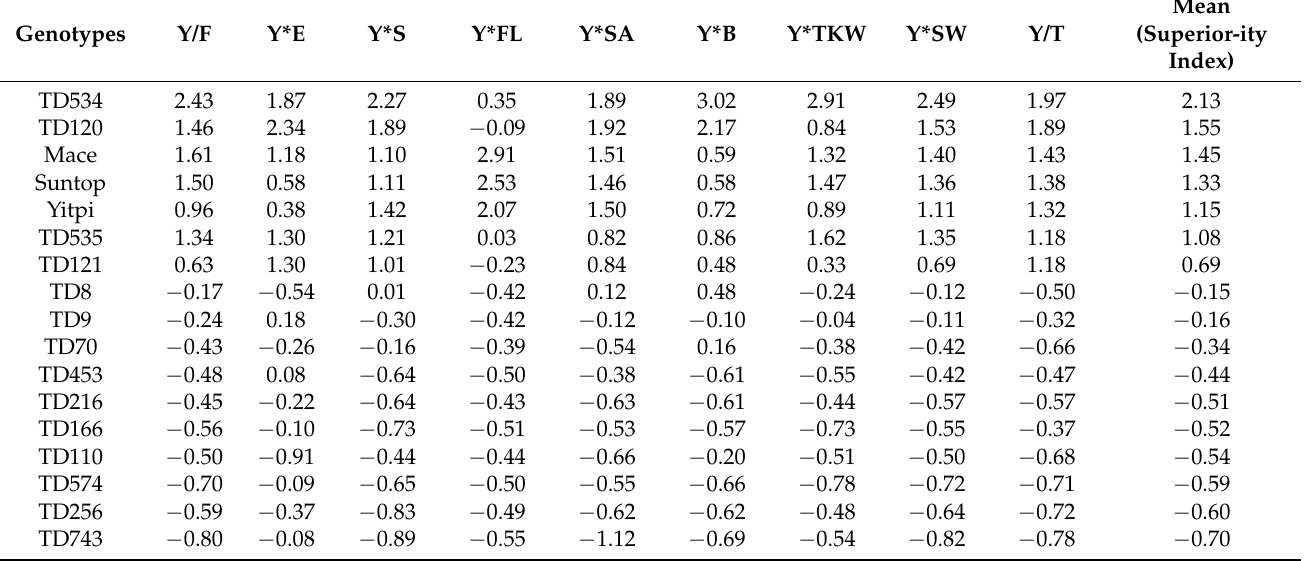
Table 3. Standardized genotype by yield*trait (GYT) data along with superiority index for the top 23 genotypes. The trait abbreviations are Y: Yield; F: Flowering time; E: Effective tiller number; S: Spike length; FL: Flag leaf area; SA: Shoot angle; B: Biomass/plant; TKW: Thousand kernel